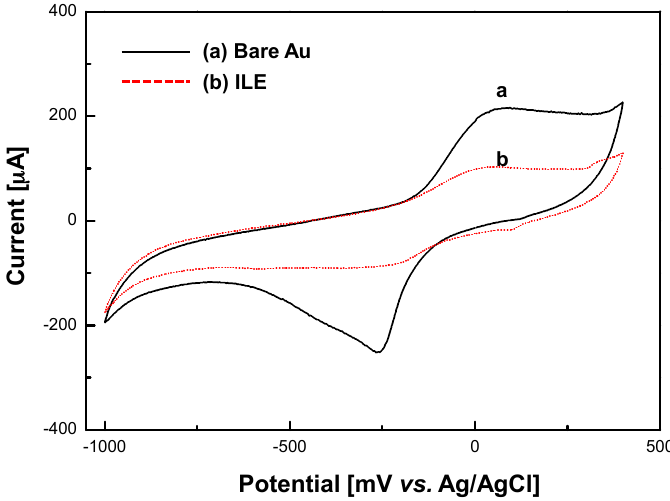
Figure 2. Electrochemical measurements (cyclic voltammogram) onto bare Au electrode (curve a, solid line) and immobilized-liposome electrode (curve b, dot line) were carried out in 1 mM Na 2 SO 4 as a background electrolyte solution at 100 mVs − 1 of the scan rate.